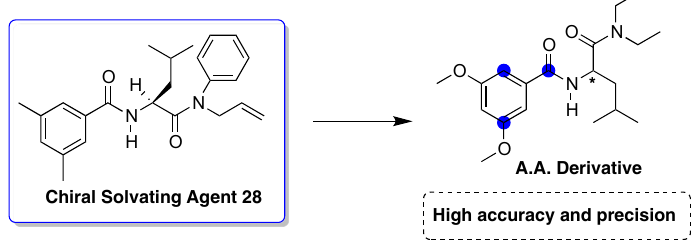
Scheme 21. Prediction of Δδ RS for 13 C nucleus of chiral organic compounds.